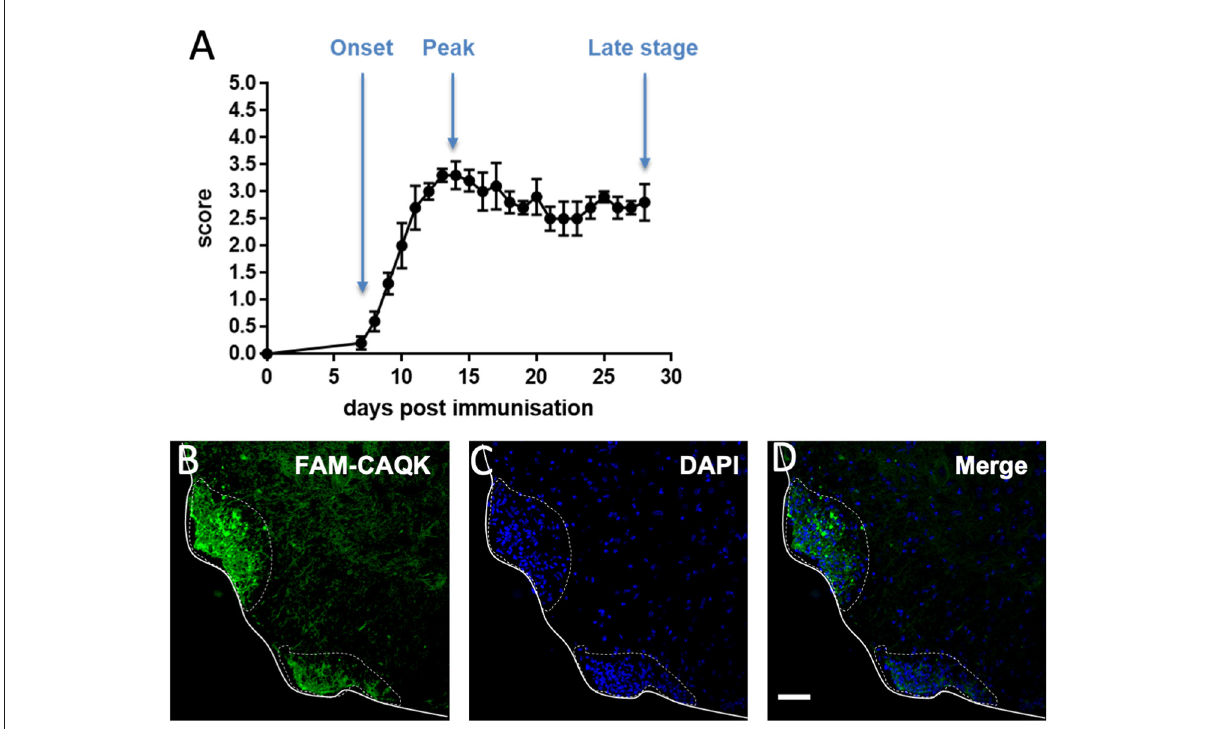
FIGURE5 CAQK homes to demyelinating lesions in the mouse model of experimental autoimmune encephalomyelitis (EAE). (A) Disease scores over a 28-day period show EAE progression with an average 7-day onset and a 14-day peak. Control mice show no disease. (B) FAM-CAQK (green) accumulates at lesion sites in the lumbar spinal cords of mice with EAE. Lesions are indicated by clusters of DAPI-stained nuclei (blue) in (C) representing invasions of peripheral inflammatory cells, prominently T-cells and macrophages, into the spinal cord parenchyme. Merged images are shown in (D) . Continuous line delimitates the spinal cord tissue. The dotted line indicates area of active EAE lesion. Scale bar: 50 µ